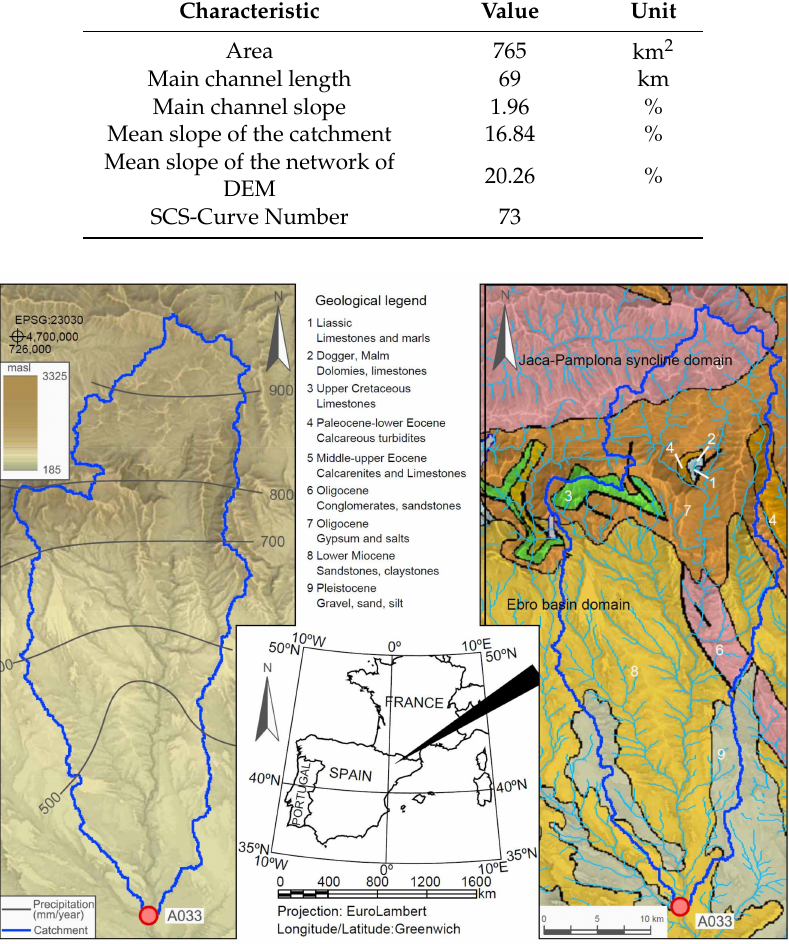
Figure 2. Study area with the water divide of the catchment, altimetry shade with Ski View Factor algorithm, geological synthesis and drainage